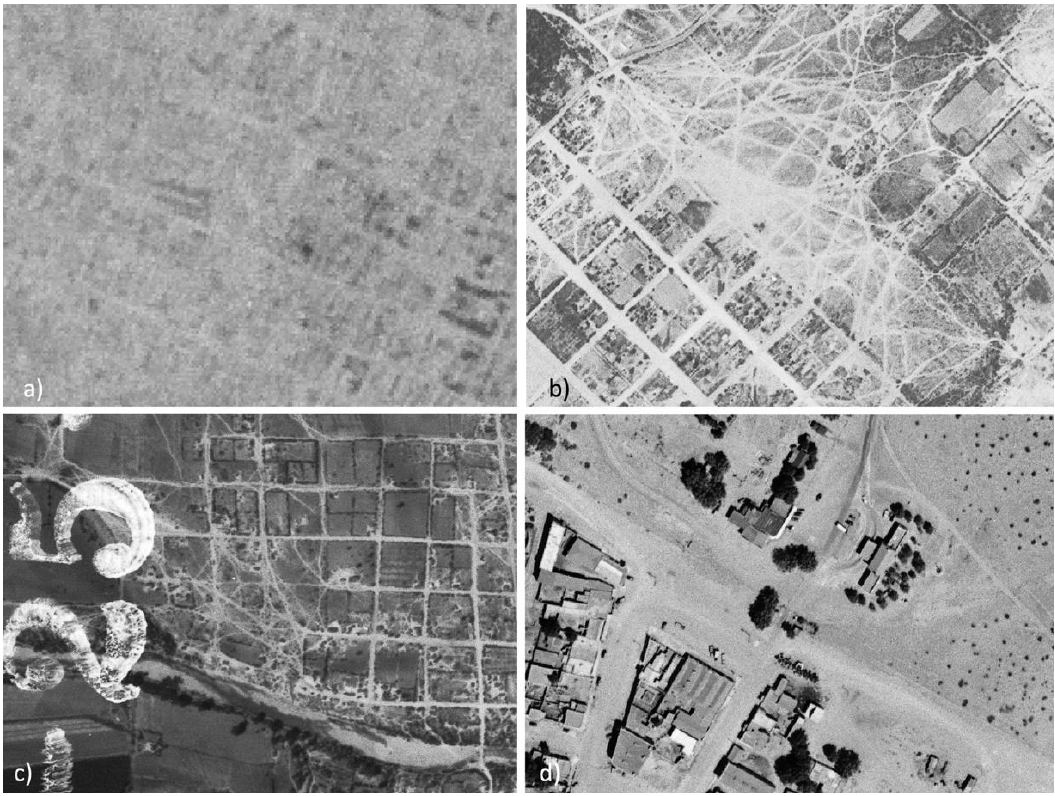
Figure 8. Four examples and close-ups of aerial images used and their original mapping resolutions; ( a ) Ciudad Juarez 1956 1:130.000, ( b ) 1950 Del Rio 1:46.000, ( c ) 1950 Ciudad Acuna 1:46.000, ( d ) San Luis 1946 1:12.000.